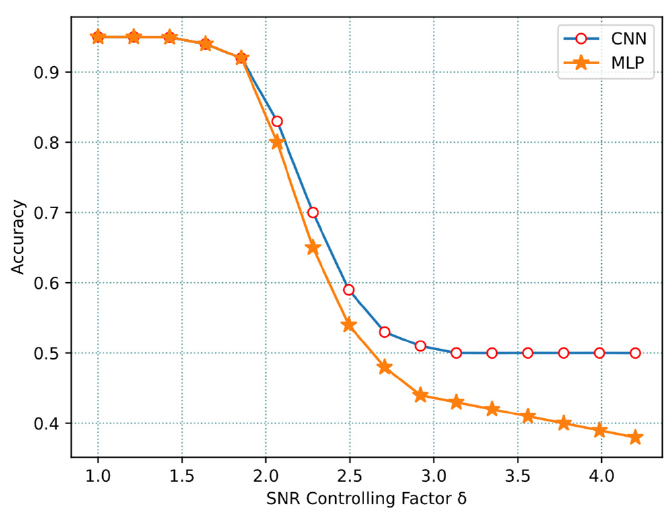
Figure 7. The performance of the proposed Siamese network for